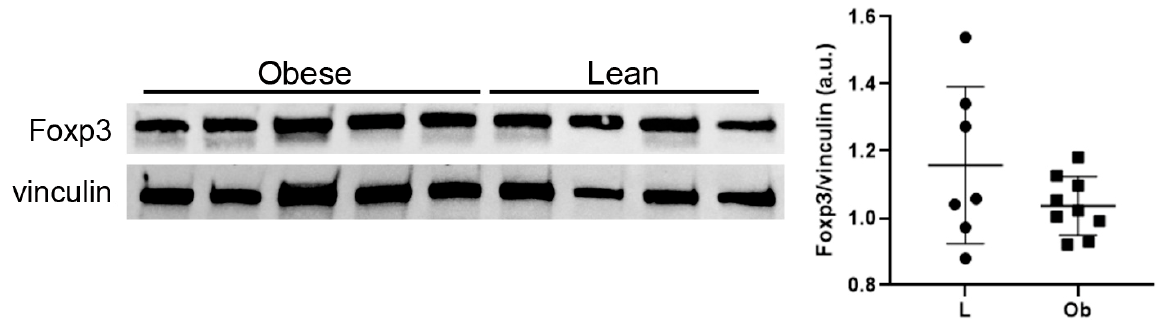
Figure 5. Western blot showed no difference in Foxp3 expression levels. Student’s t -test. Full square stands for Obese rats, while full circle stands for Lean rats